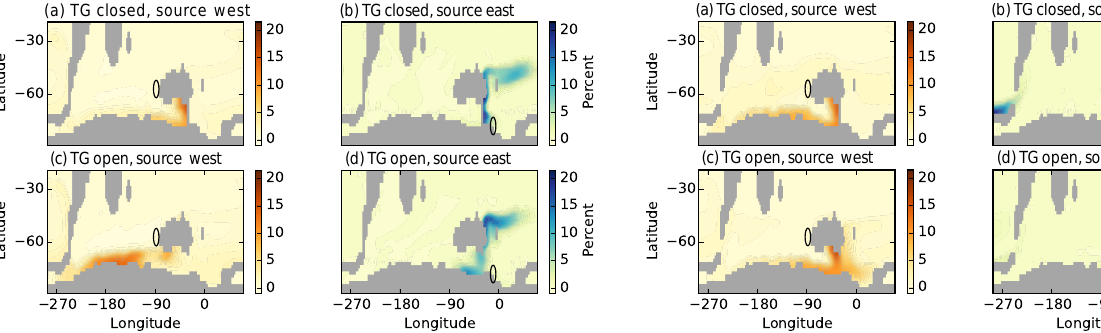
Figure 5. Dispersal of passive tracer representing dinoflagellates for the Drake Passage closed and for the Tasman Gateway (TG) closed, originating west (a) and east (b) of Australia, and for TG open, originating west (c) and east (d) of Australia. Circles indi- cate the release sites. When the TG is open, dinoflagellates released to the west of Australia enter the Australo-Antarctic Gulf predom- inantly along the Australian coast but remain west of the TG and do not enter the Ross Sea (c) . In contrast, species released near the Ross Sea may enter the gulf via a westward flow along the Antarctic coast (d) . Concentrations are in percentages, where the initial local- ized concentration upon release was 100%. We examine a snapshot taken 5 years after tracer release.